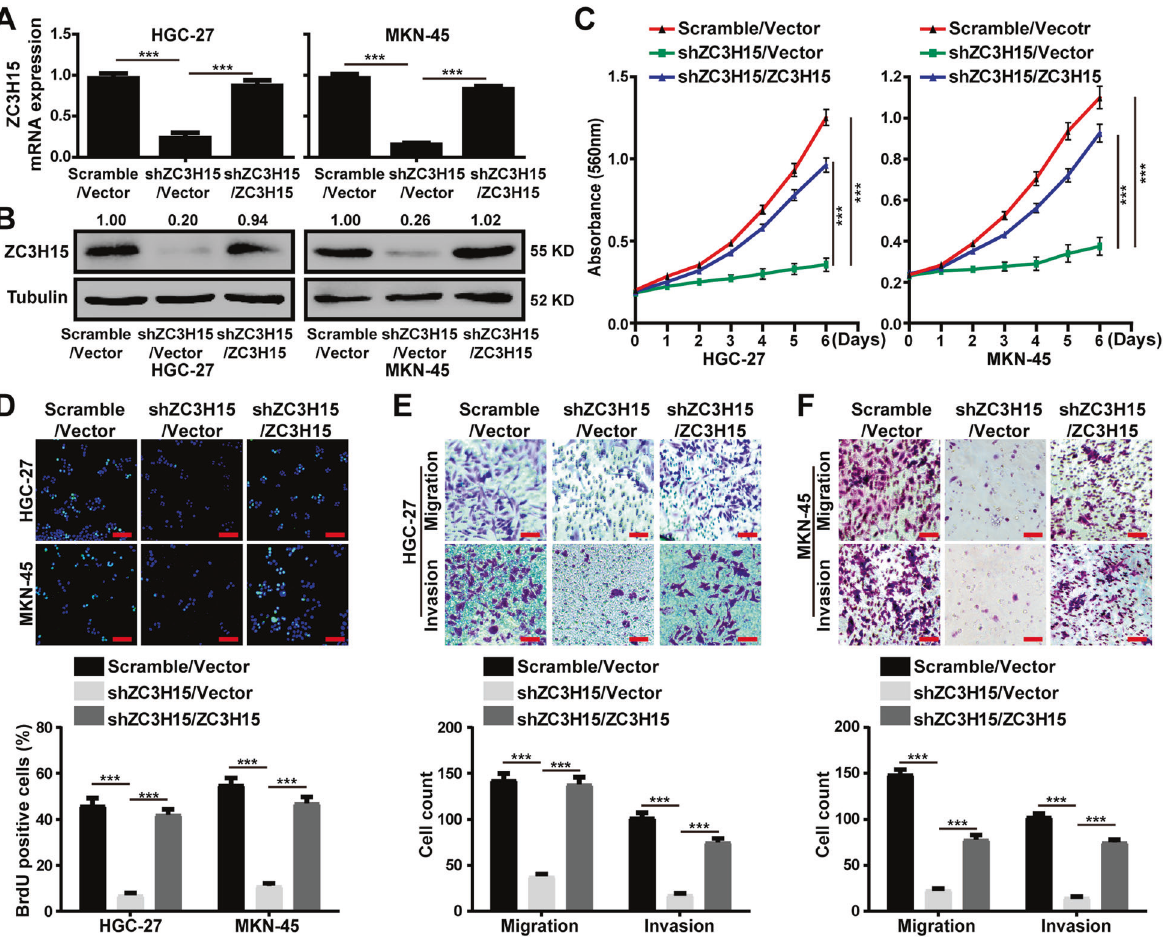
Fig. 3 ZC3H15 recovery restored the cell proliferation, migration, and invasion of ZC3H15-knockdown GC cells. A RT-PCR assays were performed to detect the expression of ZC3H15 in indicated cells. B Western blot assays were performed to detect the expression of ZC3H15 in indicated cells. C MTT assays were performed to examine the effect of ZC3H15 overexpression on the proliferation of ZC3H15-knockdown cells. D BrdU assays were performed to examine the effect of ZC3H15 overexpression on the DNA synthesis ability of ZC3H15-knockdown cells. E , F Transwell assays were used to detect the effect of ZC3H15 overexpression on the migration and invasion of ZC3H15-knockdown cells. All data were expressed as mean ± SD. Student ’ s t -test was performed to analyzed signi fi cance, * P < 0.05, ** P < 0.01, *** P <